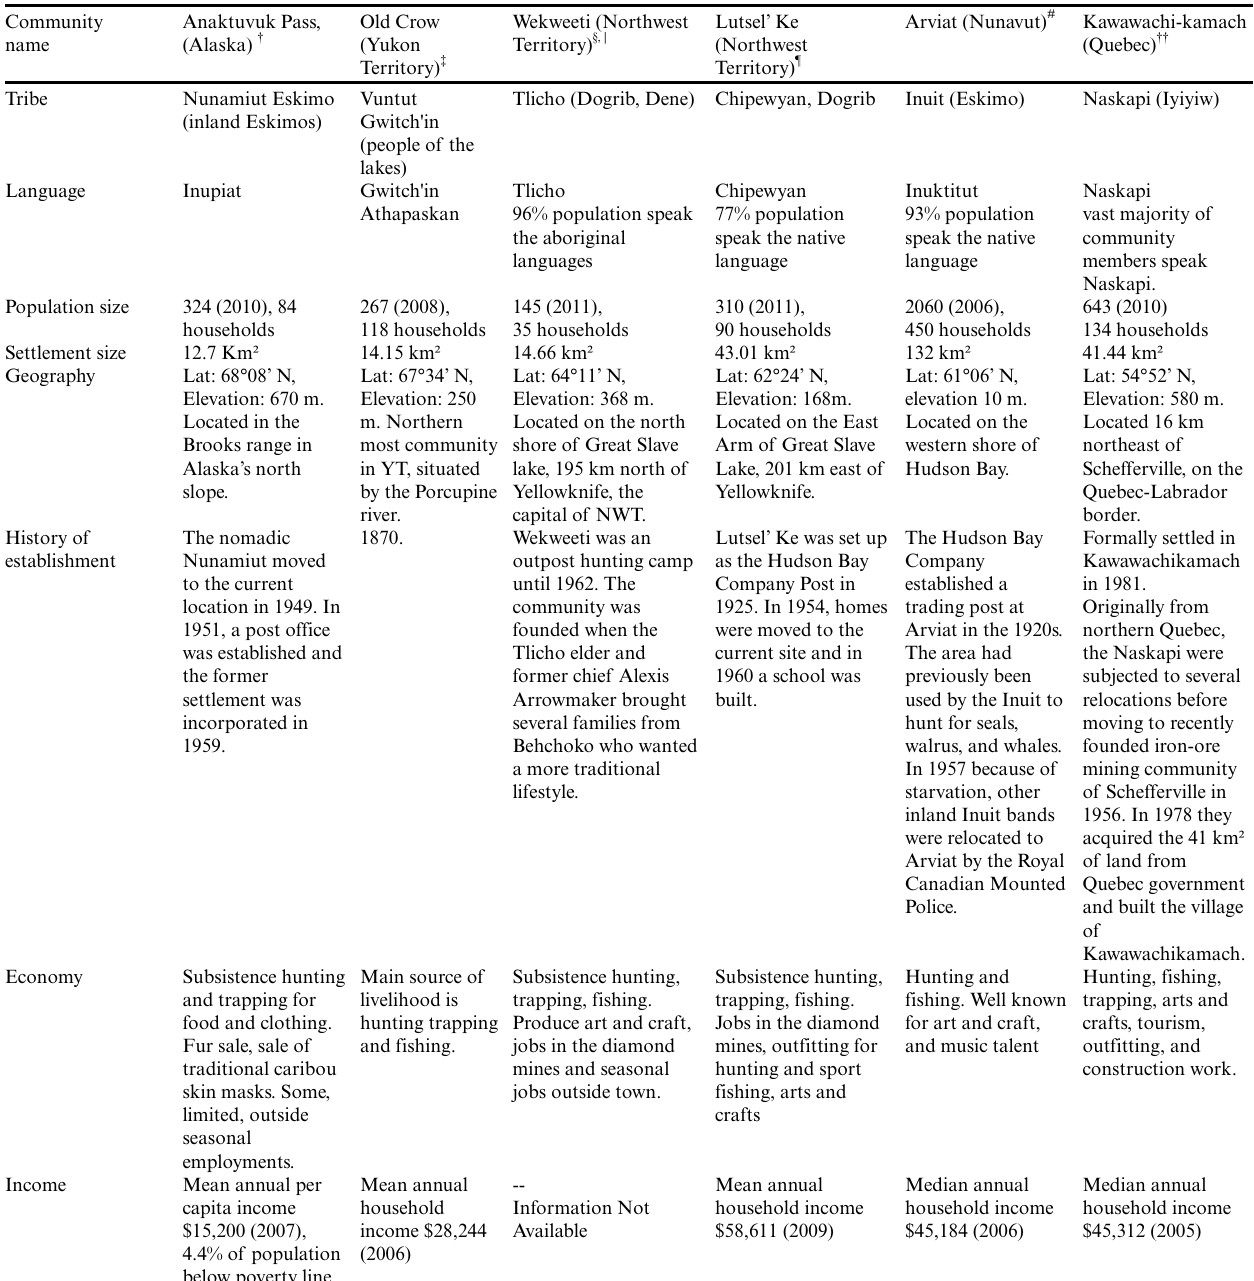
Table 3 . Profile information on the six participating communities representing heterogeneous social-ecological